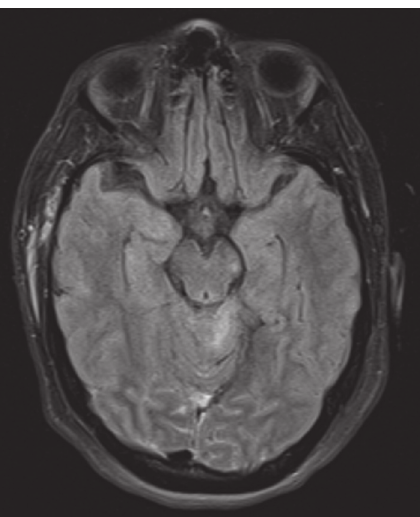
Figure 2: Axial FLAIR MRI, showing Grade III DAI with hy- perintense lesions evident in the left midbrain and